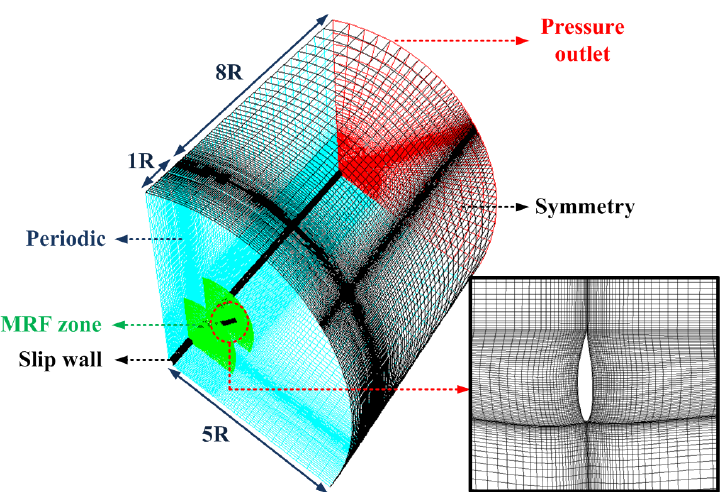
Figure 9. The mesh volume in 120 degrees section and definition of the boundary conditions and the H-type hexahedral mesh around the